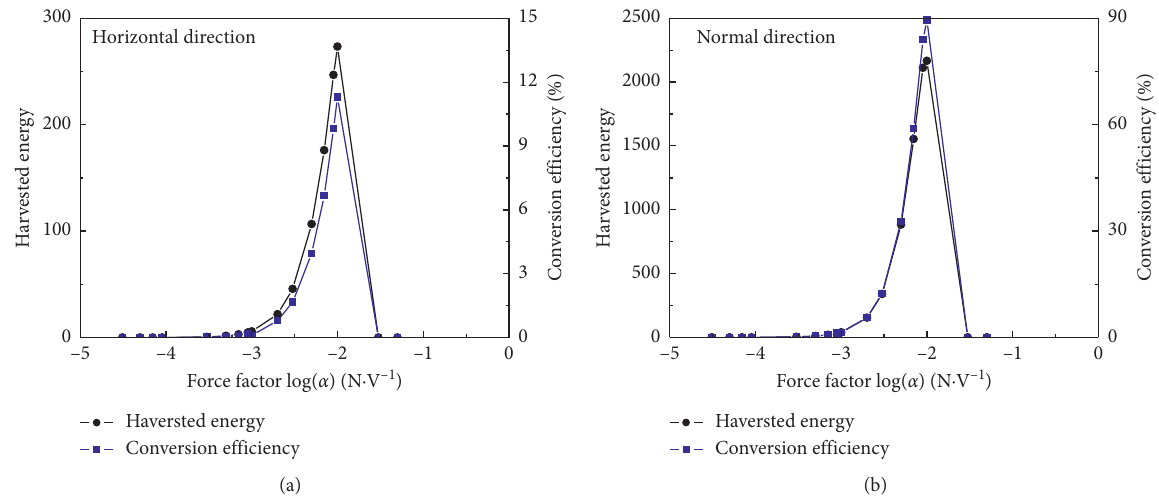
Figure 32: Considering separation, the harvested energy and conversion efficiency of the friction system in the horizontal direction (a) and normal direction (b) with different force factors of piezoelectric